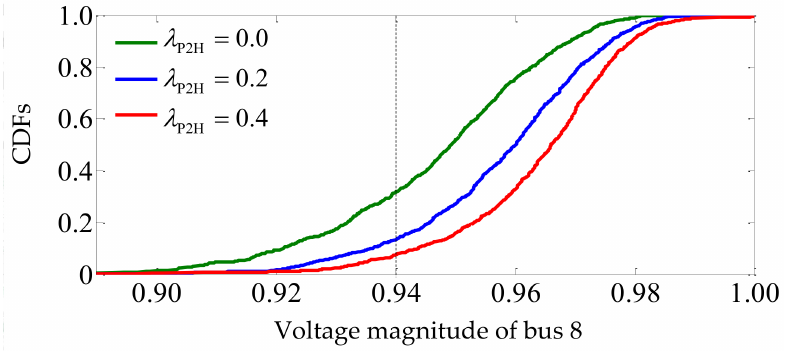
Figure 17. CDFs of voltage magnitude of bus 8.